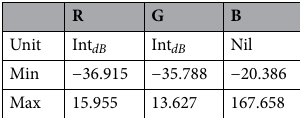
Table 7. Statistical summary of σ